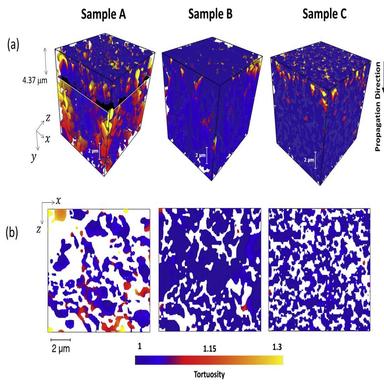
Spatial geometric tortuosity. (a) Spatial geometric tortuosity of the copper in 3D for sample A, B and C (from left to right). The propagation direction is in y- direction for sample A, B and C. Dark blue indicates a tortuosity of 1, i.e., only small deviations from the direct distance. Yellow indicates regions that are hard to reach for electrons coming from the surface and traveling in y- direction through the sample. We plot the tortuosity between 1 and 1.3. In sample A, we indicate the position of the r